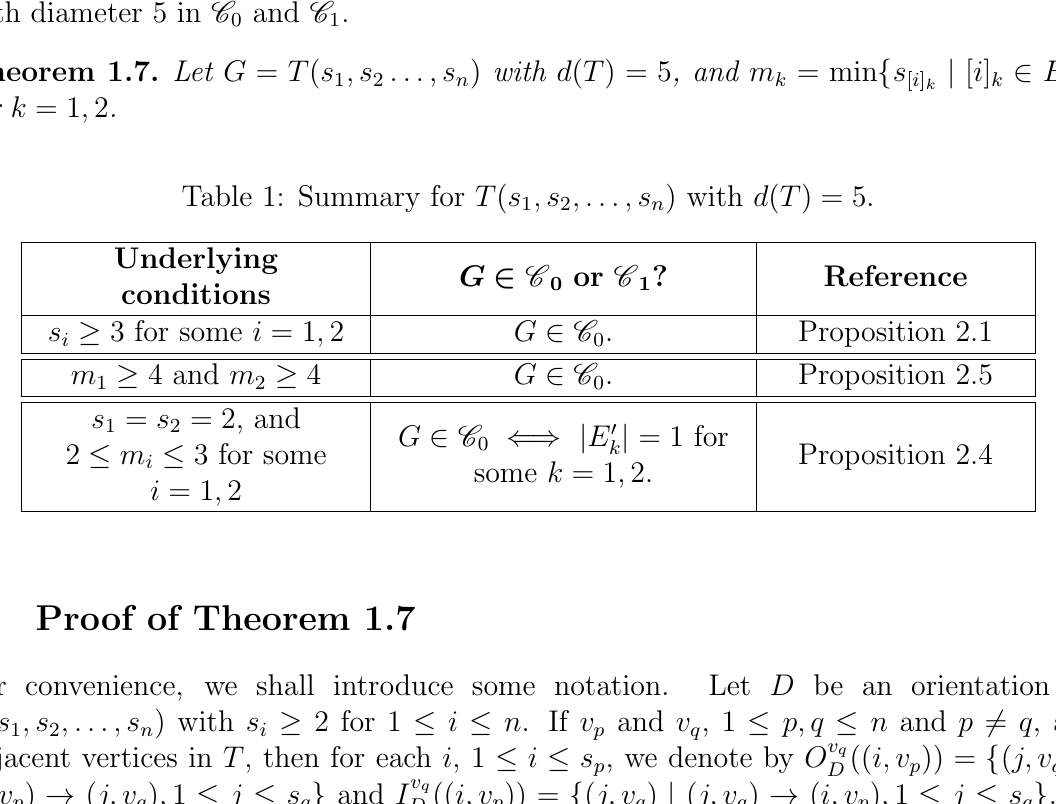
, s , . . . , s ) with d ( T ) = 5. 1 2 n G ∈ C or C ? Reference 0 1 G ∈ C 0